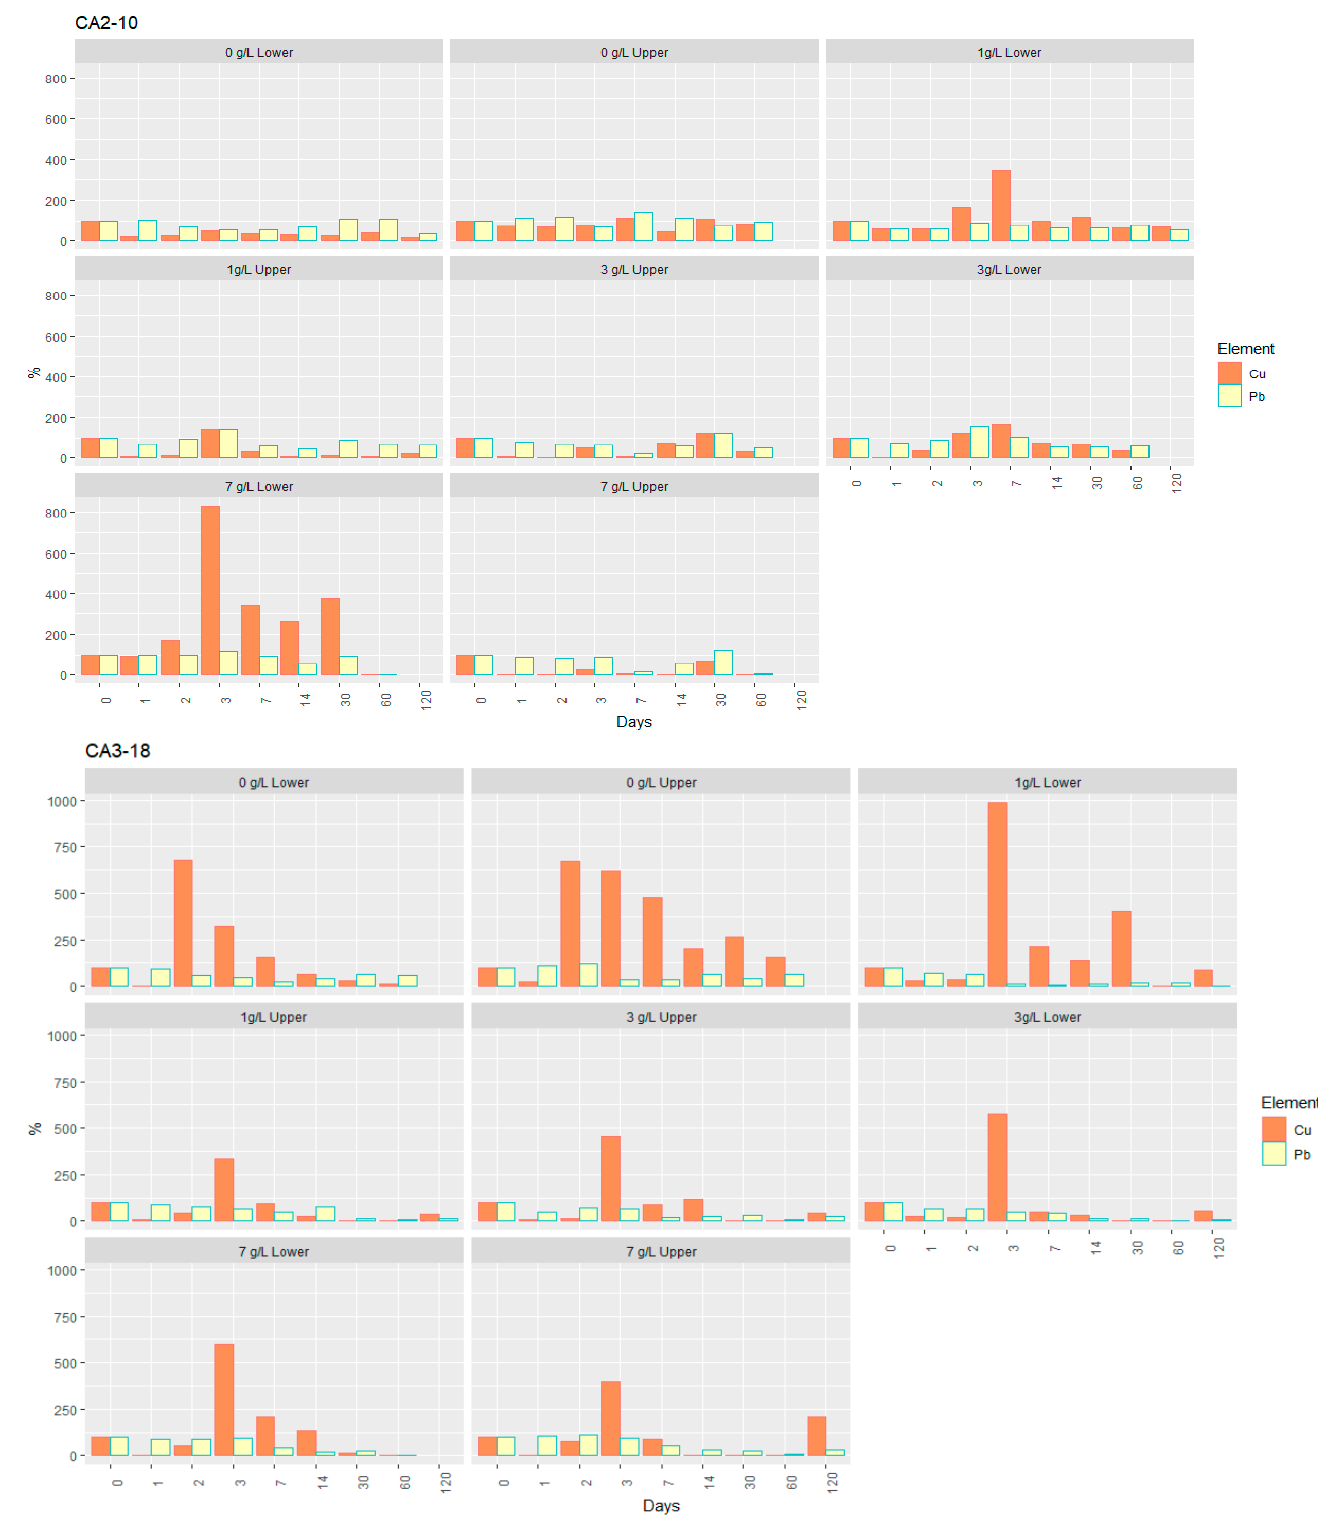
Figure 7. Changes in the Pb and Cu contents (%) in the soluble phase of samples, over 120 days of the remediation batch tests after the injection of nZVI suspension (concentrations of 0, 1, 3, and 7 g/L).